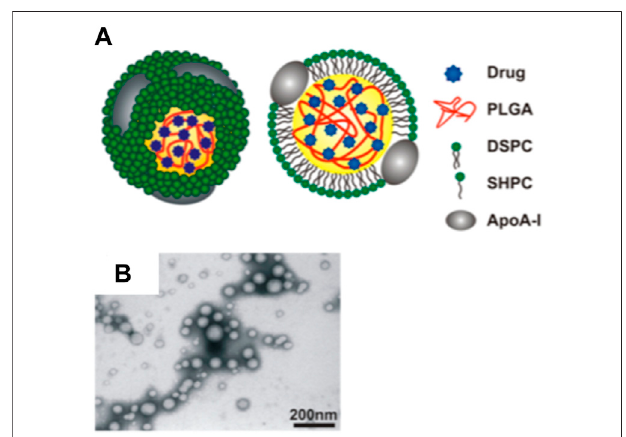
FIGURE 4 | HDL like nanoparticles. (A) Schematic demonstration of the PLGA-HDL nanoparticles with PLGA forming the polymeric core of this nanoparticle; (B) TEM images showed the spherical morphology of the nanoparticles (Copyright permission from the American Chemical